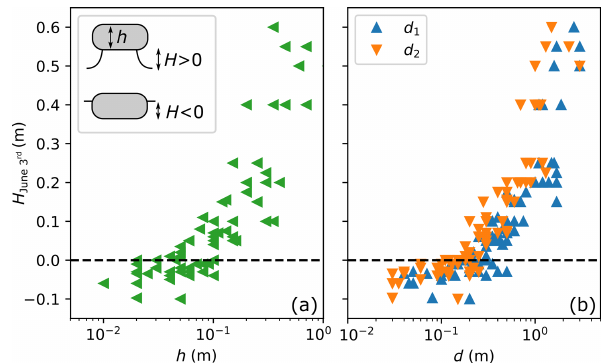
Figure 3. Raw data of the observation made at location 1 (see Fig. 2a) on 3 June 2021: height of the ice foot ( H > 0) or of the penetration depth of the rock in the ice ( H < 0) as a function of the rock thickness h (a) and widths d 1 and d 2 (b) . On the date of these observations the rocks were still standing on their ice feet and the maximum heights had presumably not been reached